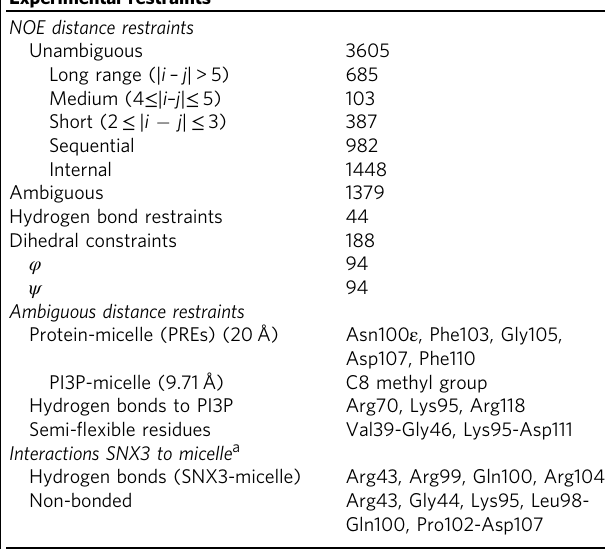
structures of SNX3 and its micelle complexes Experimental